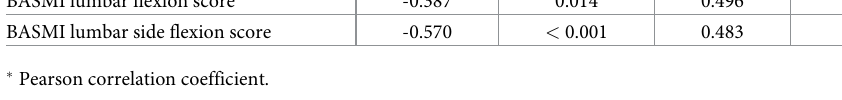
� Pearson correlation